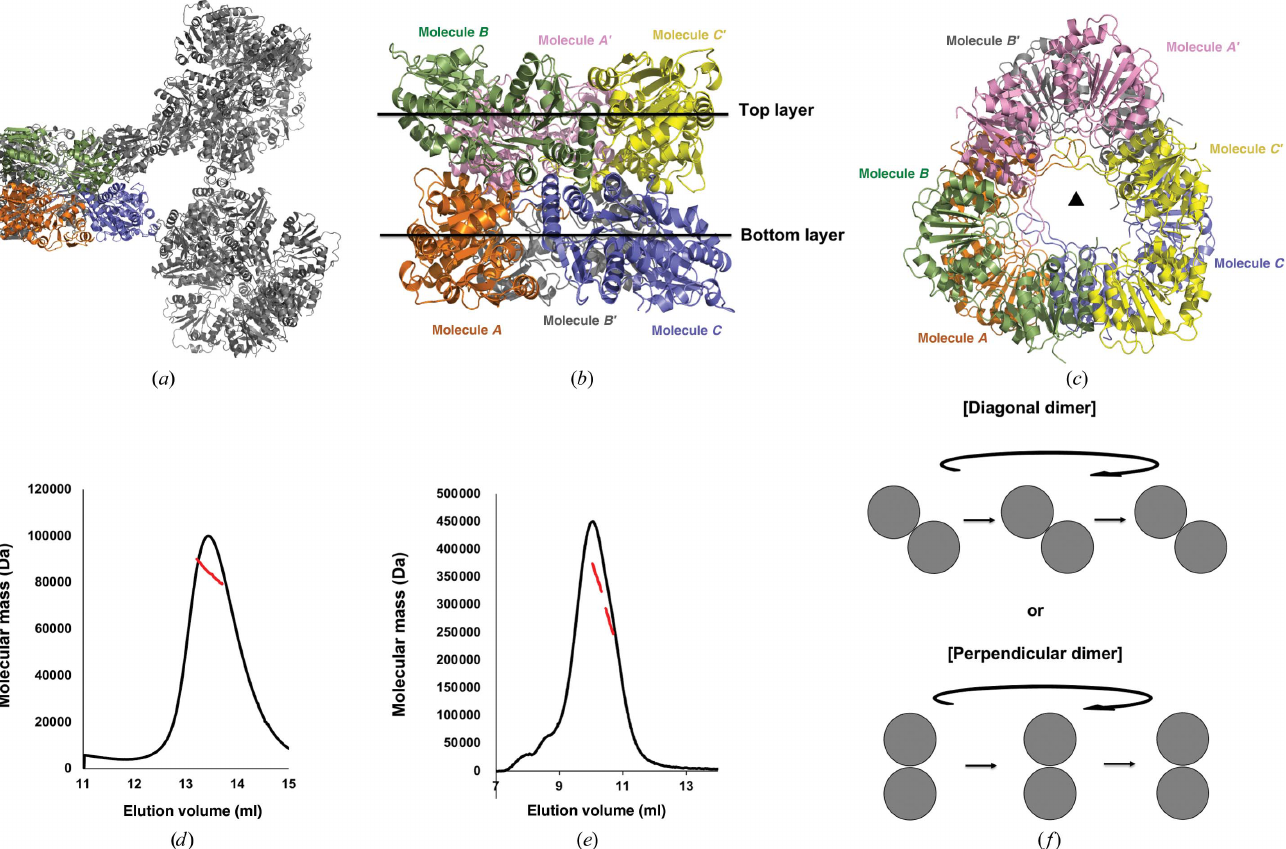
Figure 2 Hexameric structure of abMurG. ( a ) Crystallographic packing symmetry analysis. Three abMurG molecules in the asymmetric unit are indicated by color cartoons, whereas other symmetric molecules are indicated by gray ribbon structures. ( b , c ) Tentative hexameric structure of abMurG generated by the symmetry analysis: side ( b ) and top ( c ) views. ( d , e ) Multi-angle light scattering (MALS) profiles derived from the first ( d ) and second ( e ) size-exclusion chromatography peaks. The red line indicates the experimental molecular mass analyzed by MALS. ( f ) Schematic planar diagram showing the hexamer assembly strategy of two tentative